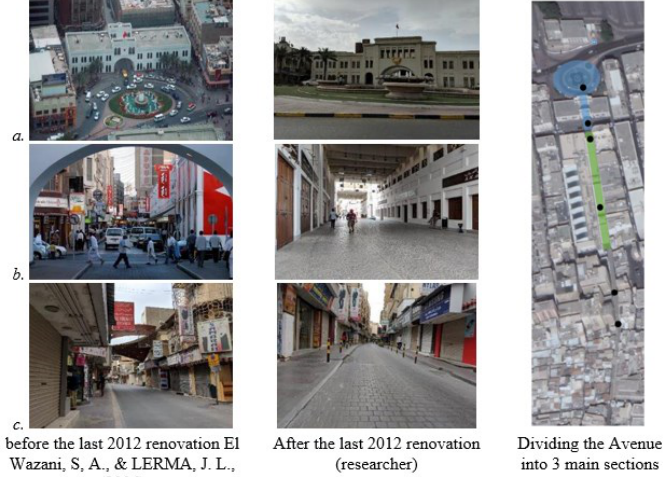
Figure 7. Analysing Bab Al Bahrain Avenue (Researcher).